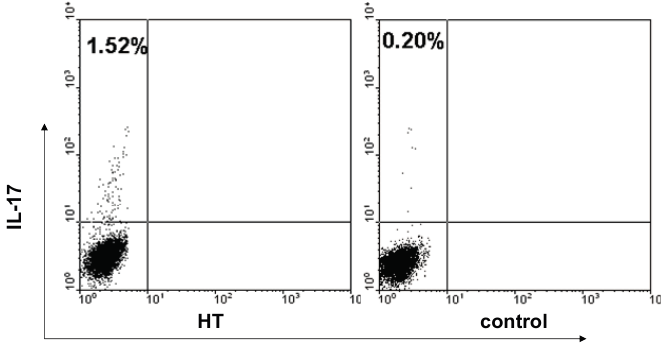
Figure 1. Enhancement of Th17 cells in peripheral blood from HT patients. PBMCs from HT patients and healthy controls were incubated with PMA/ionomycin, stained for cell surface molecules CD3 and CD8 as well as intracellular IL-17 and analyzed by flow cytometry. ( a ) Representative dot plots from HT patient and healthy control are shown. Values correspond to the percentage of Th17 cells. We used isotype controls to determine the positive cells, and all the values are gated on the CD3 + CD8 − cells; ( b ) Percentages of Th17 cells were compared between HT patients and healthy controls; ( c ) Levels of ROR- γ t mRNA in PBMCs from HT patients and healthy controls; ( d ) Serum levels of IL-6 were determined by ELISA in serum samples from HT patients and healthy controls and ( e ) Serum levels of IL-23 were determined by ELISA in serum samples from HT patients and healthy controls. ** p < 0.01; *** p <